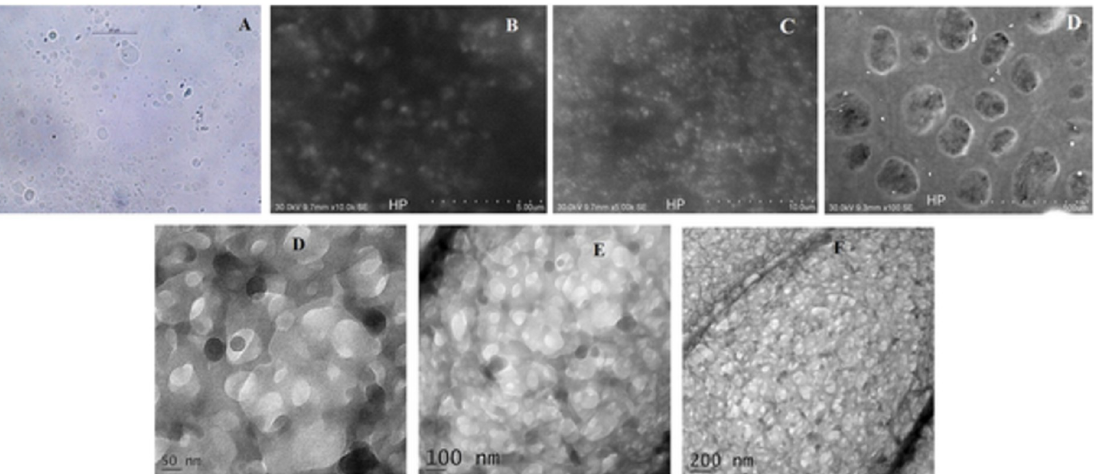
PLOS ONE | https://doi.org/10.1371/journal.pone.0274916 November3,